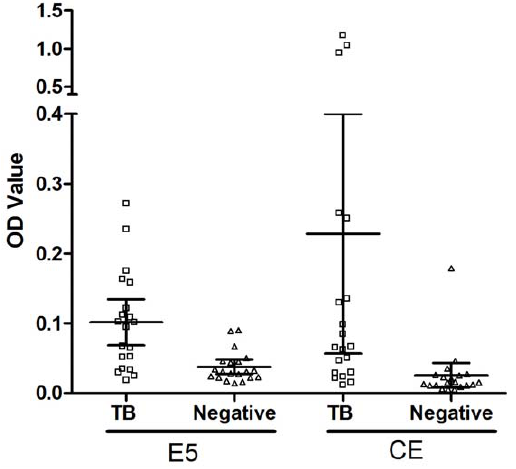
Figure 5. Scatter dot plot representation of the distribution of IgG levels to the E5 phage clone and CE protein in TB patients ( % ) and negative control ( n ). (Error bars: 95% confidence interval for mean) The plates were coated with 10 10 phages ml 2 1 or 1 m g CE protein ml 2 1 per well, as described in Methods. Sera from TB patients (n=20) and healthy individuals (n=20) were tested. The results are shown as the mean OD value of each triplicate sample read 20 min after the addition of substrate. Significance was determined against the negative controls group of E5 phage clone and CE protein (t=3.877, P=0.0004; t=2.460